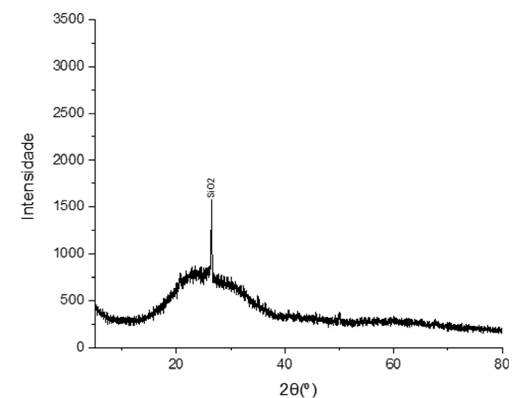
Figure 6. Diffractogram of the glass powder.